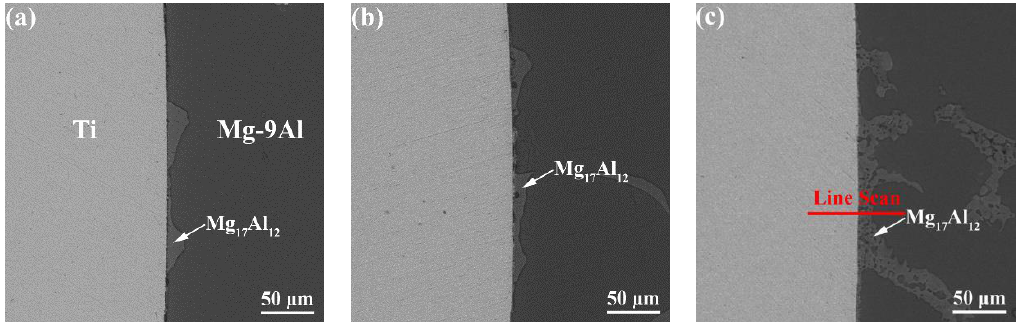
Figure 3. Cross-sectional backscattered electron (BSE) micrographs of interfaces between Mg-9Al matrix and Ti rod obtained at 700 °C for ( a ) 0 min, ( b ) 30 min, ( c ) 60 min.